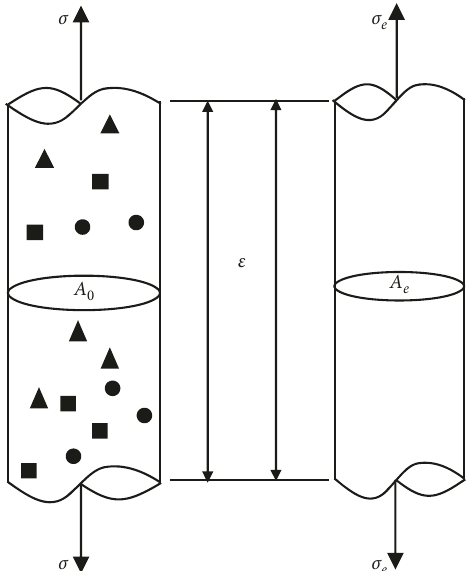
Figure 7: Schematic diagram of the damage in a bar specimen under uniaxial tension [37].